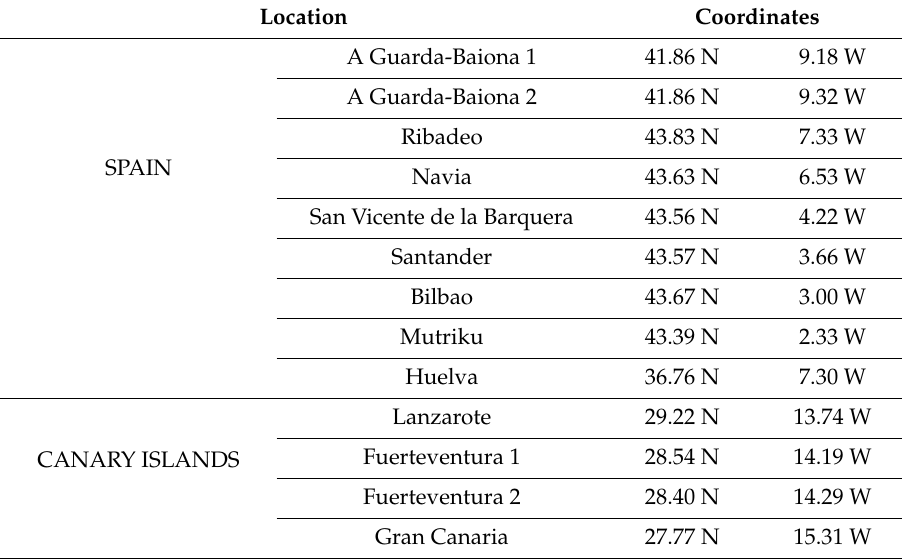
Table 3. Coordinates of the